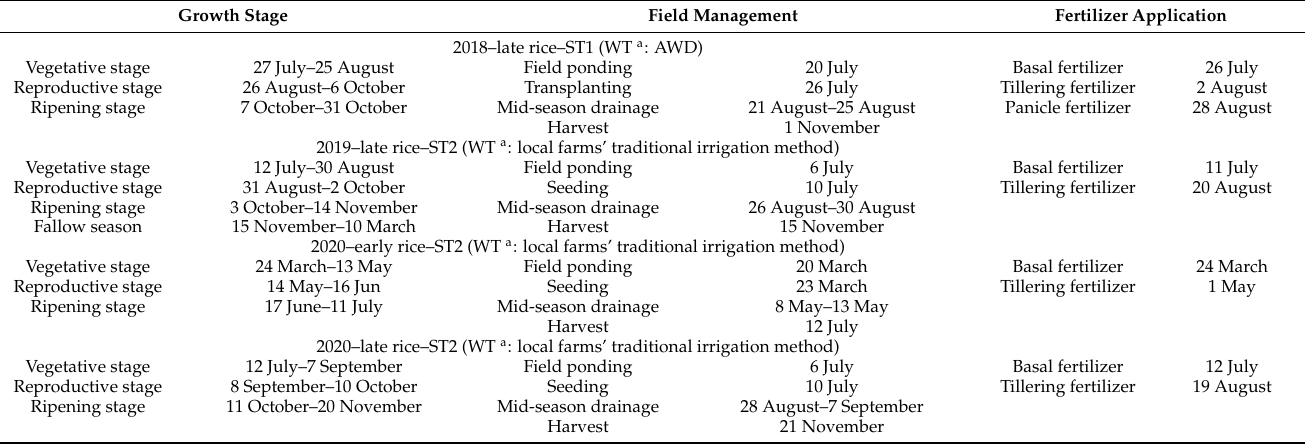
Table 1. Crop management for ST1 and